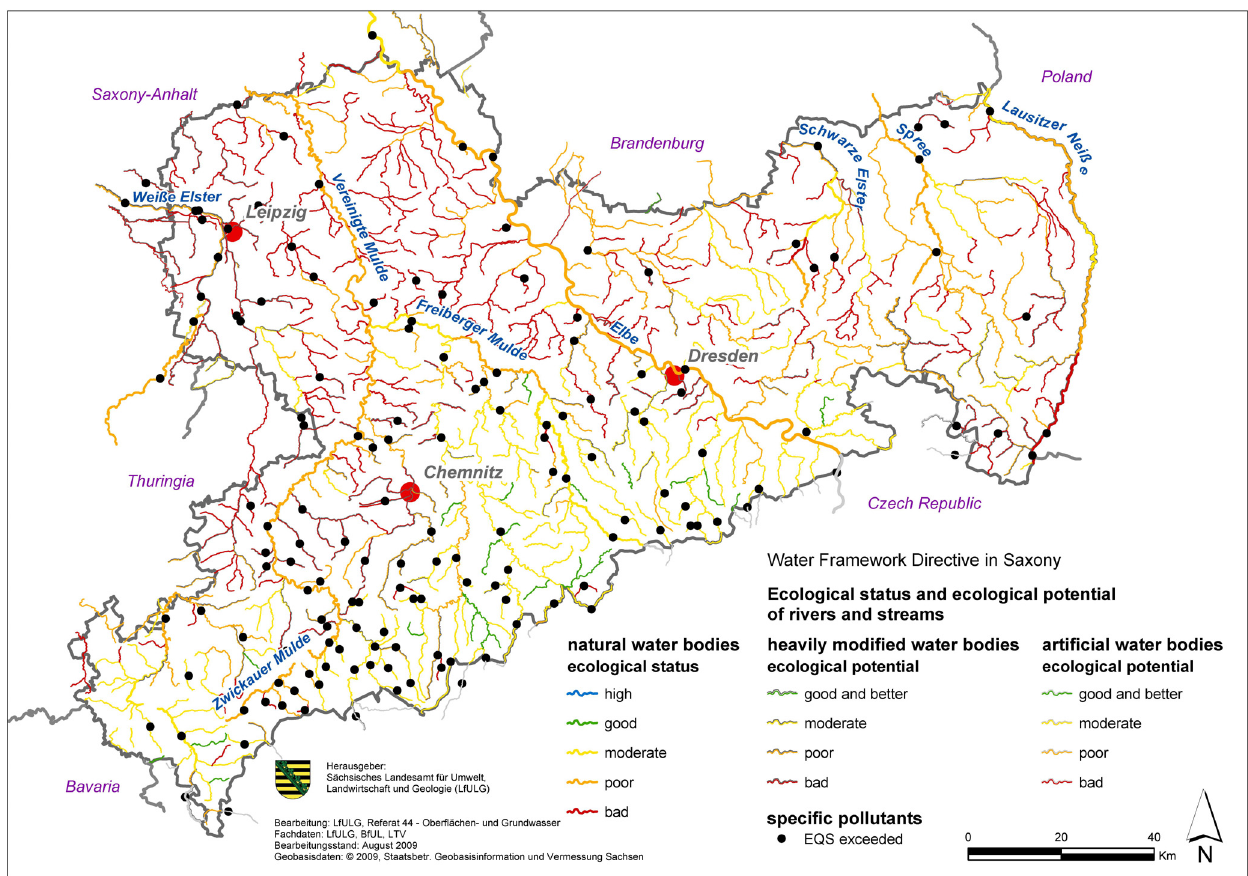
Figure 4. Ecological status and potential of stream and river water bodies in Saxony.